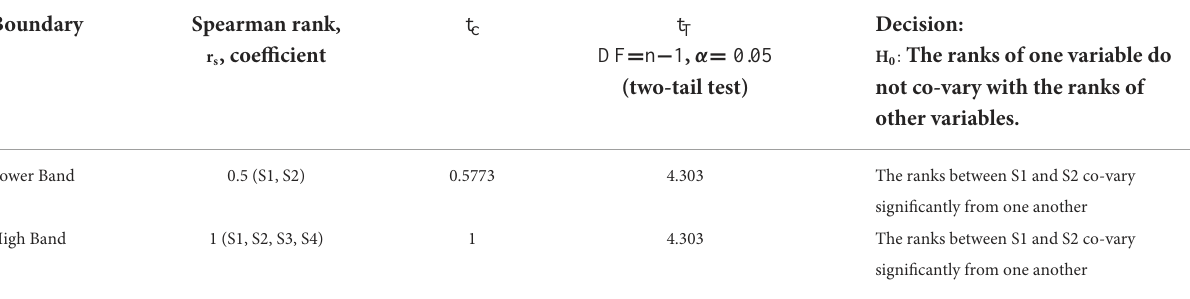
TABLE 9 Spearman rank test and the t -test of